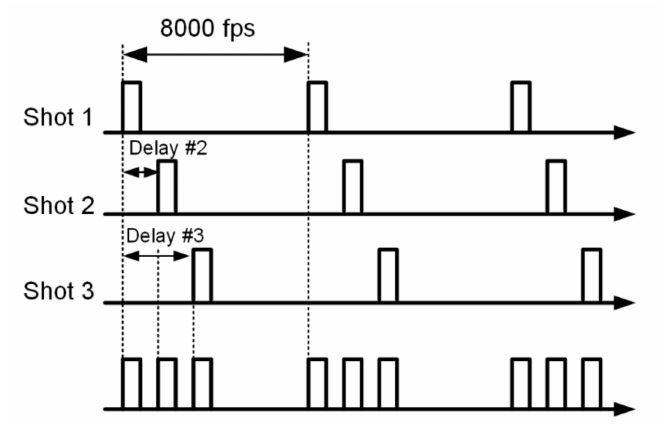
Figure 3. Alignment of the microscopic images (@8000 fps) in the time domain resulting in an e ff ect equivalent to a higher frame